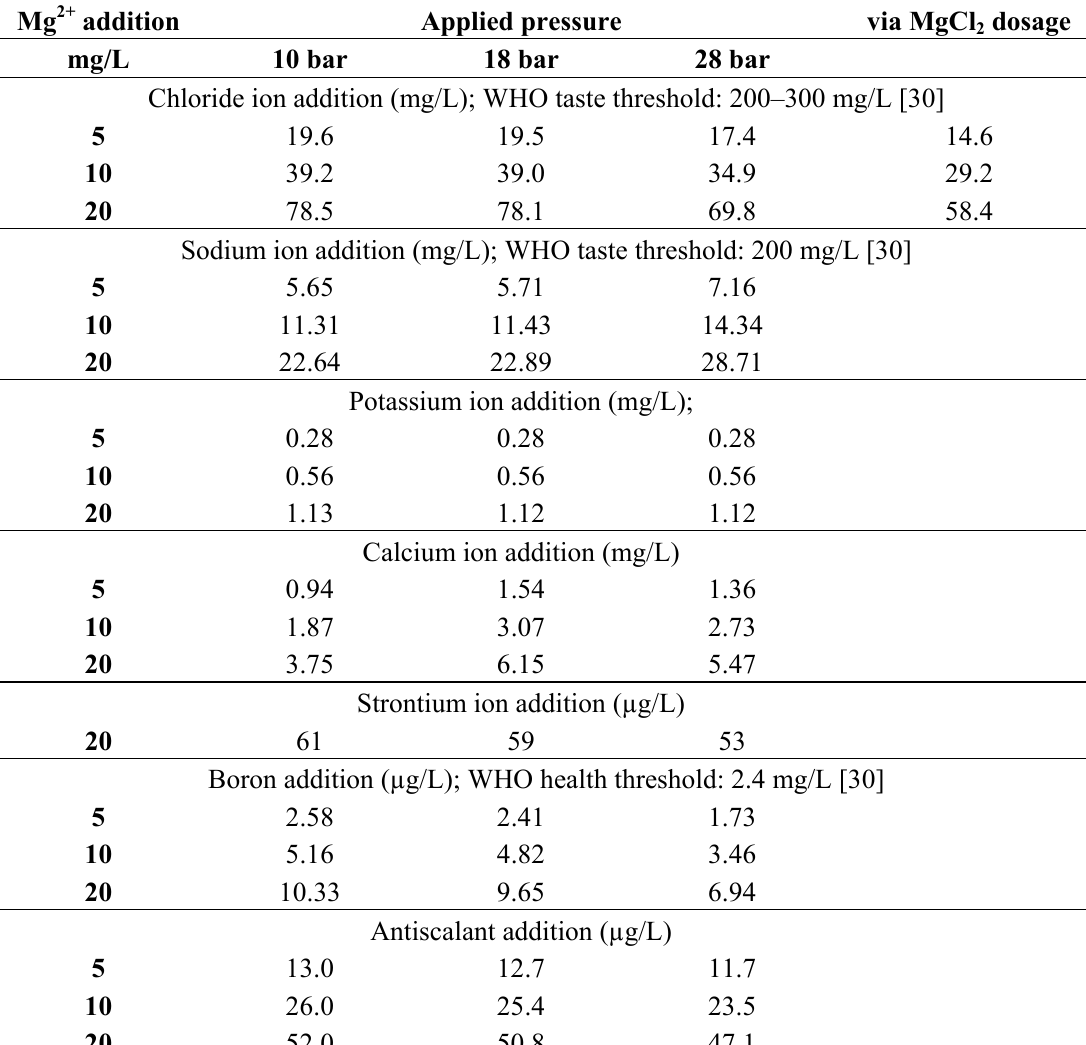
Table 1. The addition of ions (Cl − , Na + , K + , Ca 2+ , Sr 2+ and B) and antiscalant agent to the desalinated water in the nine examined scenarios and the addition of Cl − for the alternative of MgCl 2